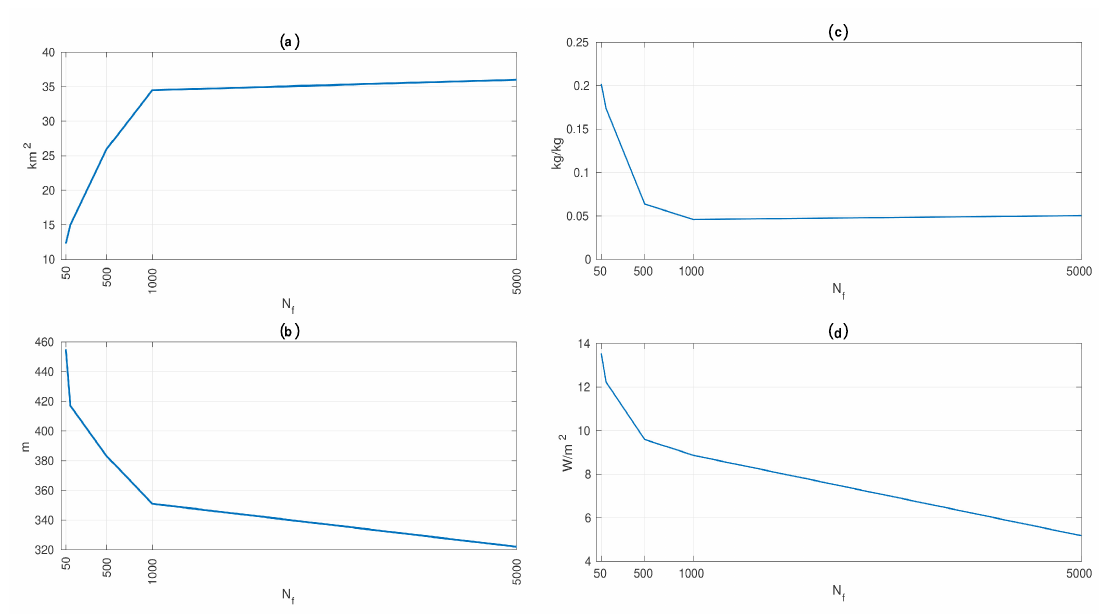
Figure 4. Time-mean total area of convective updrafts (km 2 ; a ), time-mean height reached by a convective plume (m; b ), total liquid water content (kg/kg; c ) and area–averaged sensible heat flux (W/ m 2 , d ) in function of the number of floes N f , in simulations with c = 90%, weak wind conditions (ambient wind speed 2